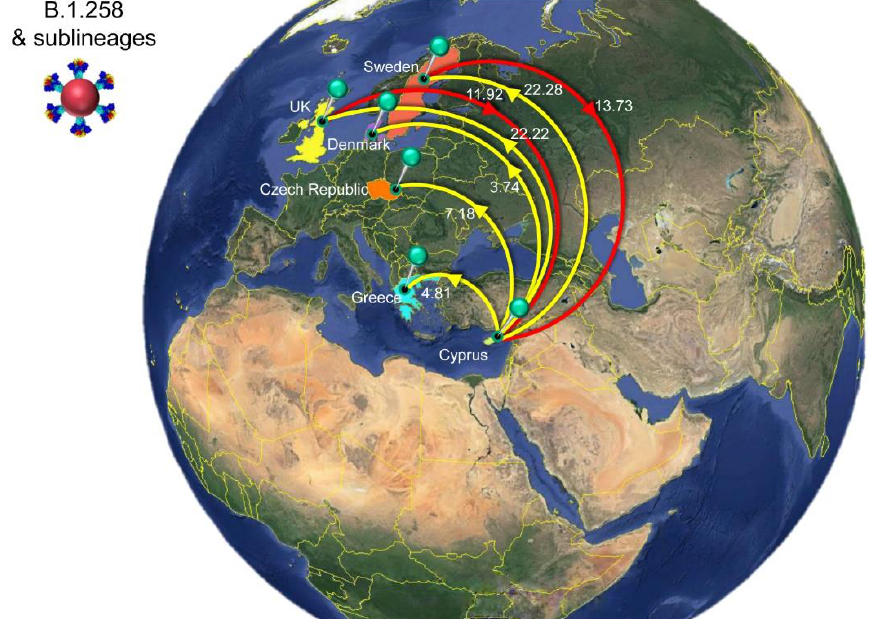
Figure 7. Map of SARS-CoV-2 B.1.258 & sublineage transmission between Cyprus and other countries. Geographic origins of SARS-CoV-2 B.1.258 and sublineages imported into Cyprus are shown as red lines; exports from Cyprus to other countries are shown as yellow lines. Countries acting as “sources” or “sinks” for SARS-CoV-2 B.1.258 & sublineage transmission are highlighted and labeled, and the estimated average number of migration events is indicated. Map images courtesy of Google Earth Pro 7.3.2.5776 (14 December 2015). Global view centered on Europe. 36°16′38.78″ N 36°07′29.71″ E, Eye alt 7949.12 km. US Dept. of State Geographer, DATA SIO, NOAA, U.S. Navy, NGA, GEBCO. Image Landsat/Copernicus. 2018 © Google. https://www.google.com/earth/versions/#earth-pro (accessed on 10 April 2019).